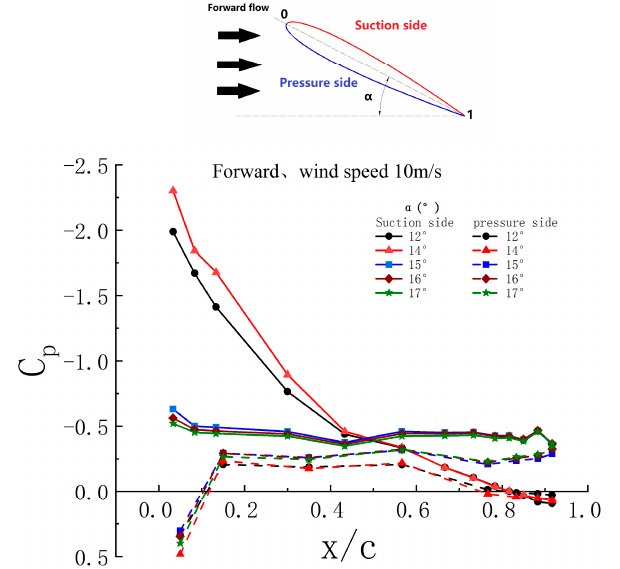
Figure 12. Pressure coefficient of suction and pressure sides of airfoil under forward-blowing. It is found that before stall occurs when the angle of attack is 12° and 14°, there is a strong suction peak on the aerodynamic leading edge of the airfoil suction side, and only a small part of the aerodynamic trailing edge of the entire suction side is a positive pres- sure zone. The pneumatic pressure side is in the low negative pressure area as a whole;